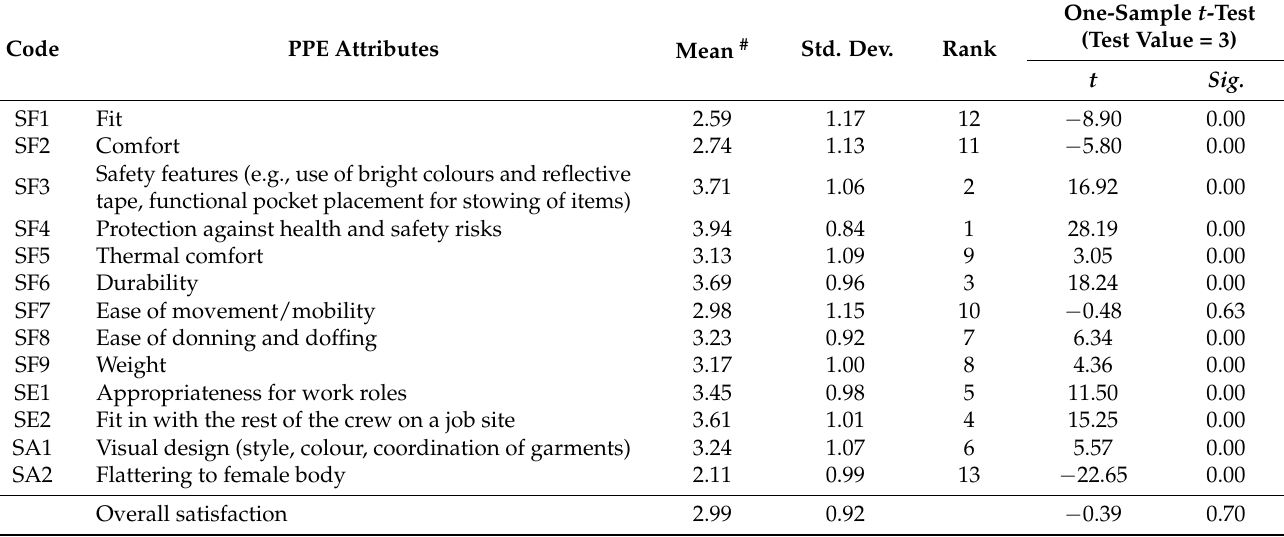
Table 3. The respondents’ satisfaction with the functional, expressive and aesthetic (FEA) need attributes of